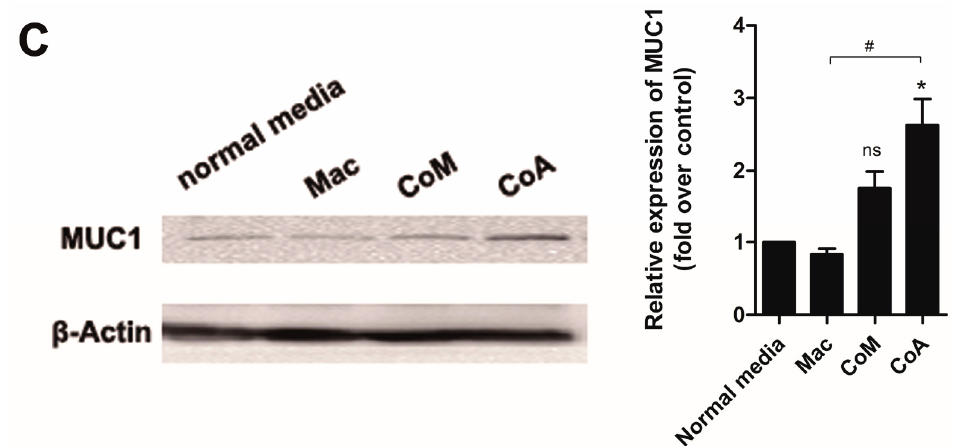
Figure 3. Analysis of the proliferative abilities of sorted CD44 + /CD24 − and CD44 + /CD24 + subpopulations of MCF-7 cells and Mucin1(MUC1) protein levels in MCF-7 cells cultured in four types of media. ( A ) 3-(4,5-dimethylthiazol-2-yl)-5-(3-carboxymethoxyphenyl)-2- (4-sulfophenyl)-2 H -tetrazolium (MTS) assay examining the proliferative ability of the CD44 + /CD24 − cells of the three groups. Results are typical of the three independent experiments. Data represent means ± S.E. ( n = 3). *** p < 0.001 vs. the normal media group; ( B ) MTS assay examining the proliferative ability of the CD44 + /CD24 + cells of the three groups. Results are typical of the three independent experiments. Data represent means ± S.E. ( n = 3); ( C ) Western blot analysis of MUC1 levels. Band intensity was analyzed using Quantity One software and β -actin was used as a loading control. Protein levels were compared to the normal media group. Results are typical of three independent experiments. Data represent means ± S.E. ( n = 3). * p < 0.05, vs. the Normal media group; # p < 0.05 vs. the Mac group; ns means no